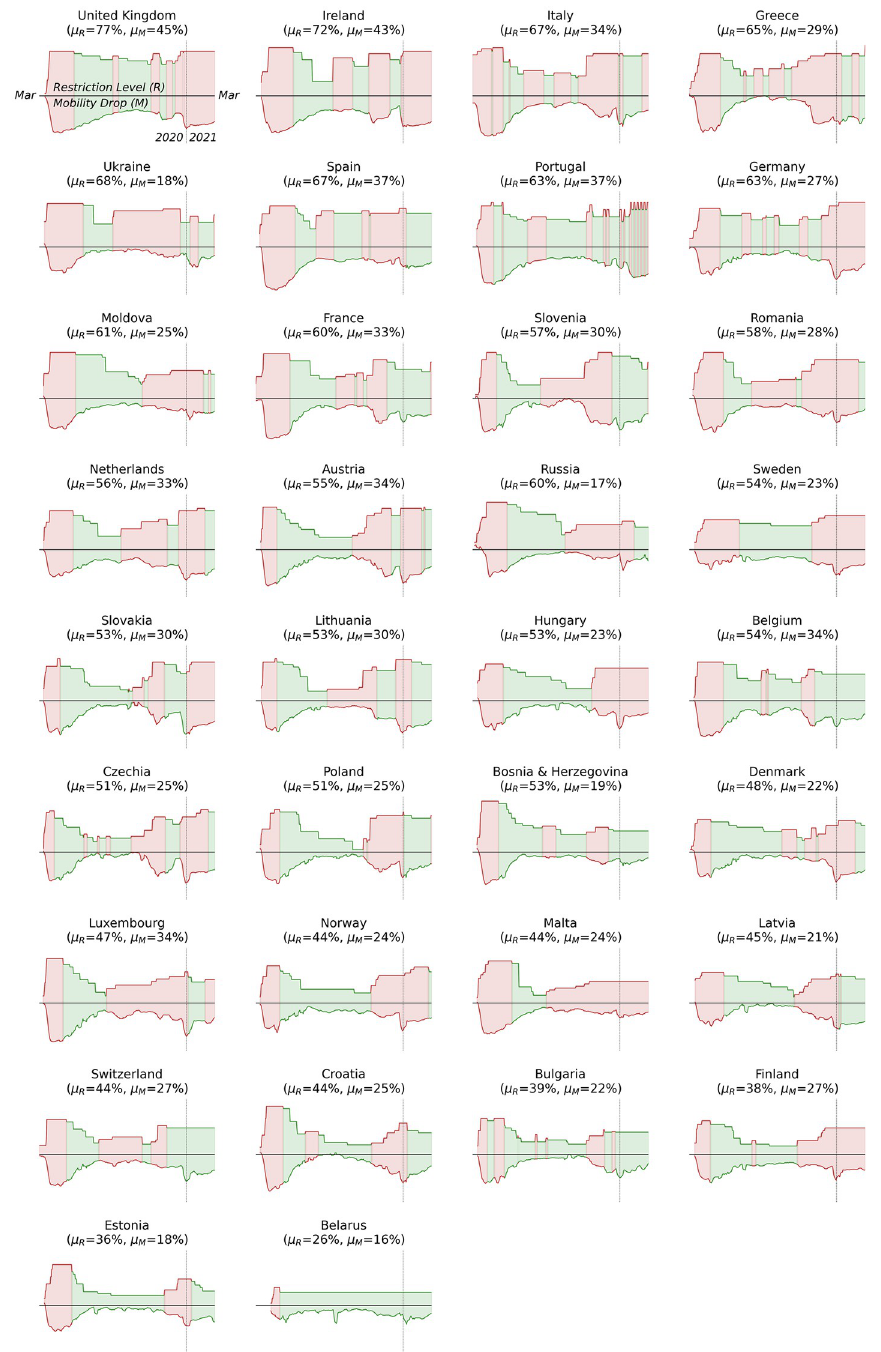
Fig 2. The travel-related restrictions and mobility data for 34 countries in Europe, showing periods of increasing (red) and decreasing (green) restrictions. For each country the upper graph shows the restriction level and the lower graph shows the corresponding mobility drop. Each country title also includes the mean level of restriction ( μ mobility drop ( μ M ) experienced between March 2020 and the end of February